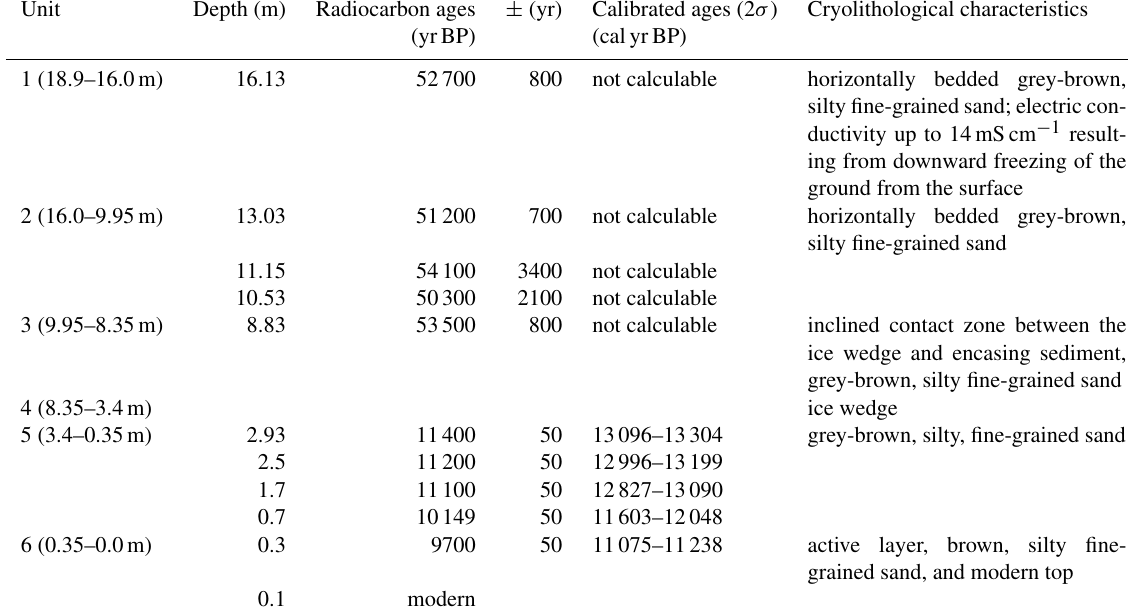
Table 1. Cryolithological units from the bottom to the top with sample depths below surface (m), radiocarbon ages given as years before present (yrBP), calibrated radiocarbon ages (calyrBP) and characteristics according to Schirrmeister et al.